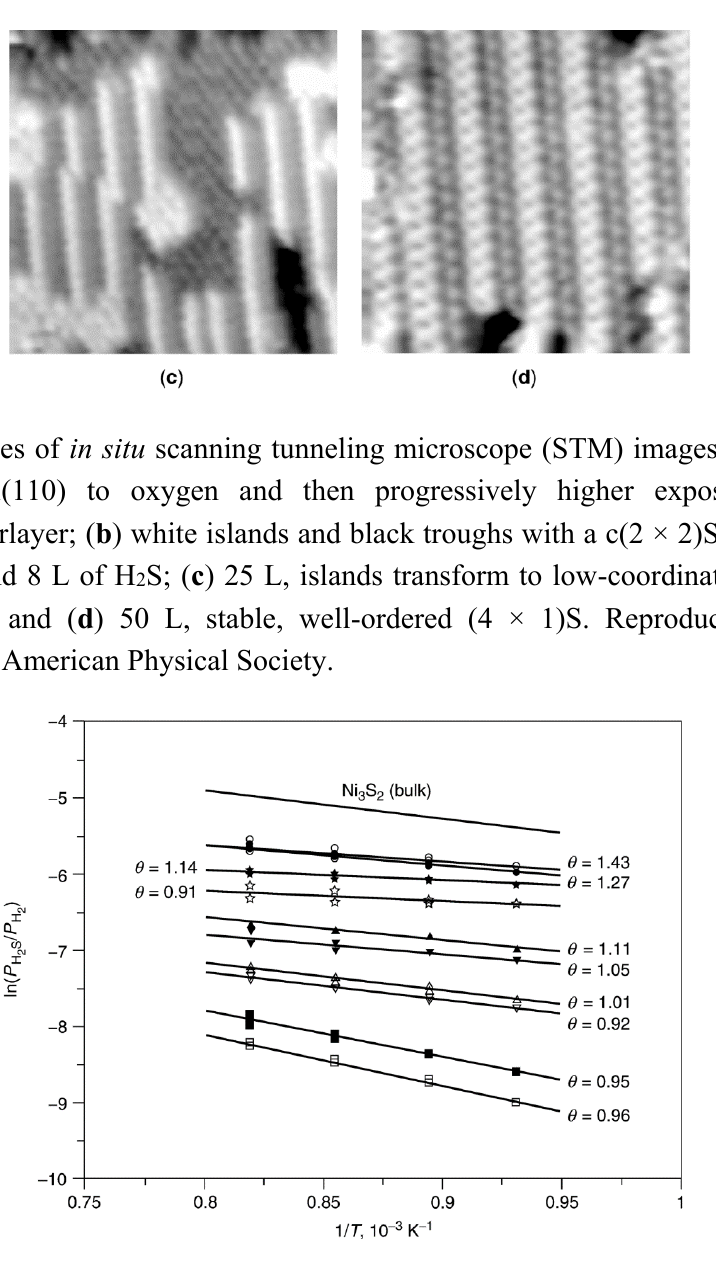
Figure 7. Sulfur chemisorption isosteres on a Ni/α-Al 2 O 3 catalyst at high temperatures and high H 2 S concentrations. Reproduced from [41]. Copyright